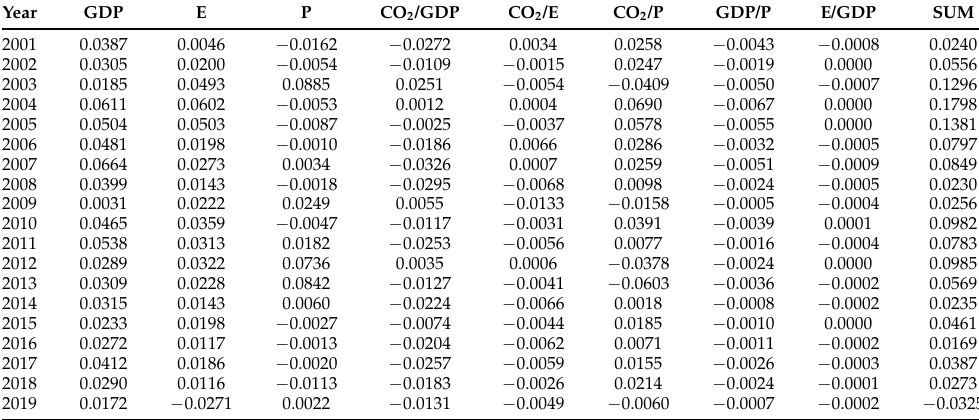
Table 4. Contribution ratio of CO 2 emissions of each decomposing factor. Unit: